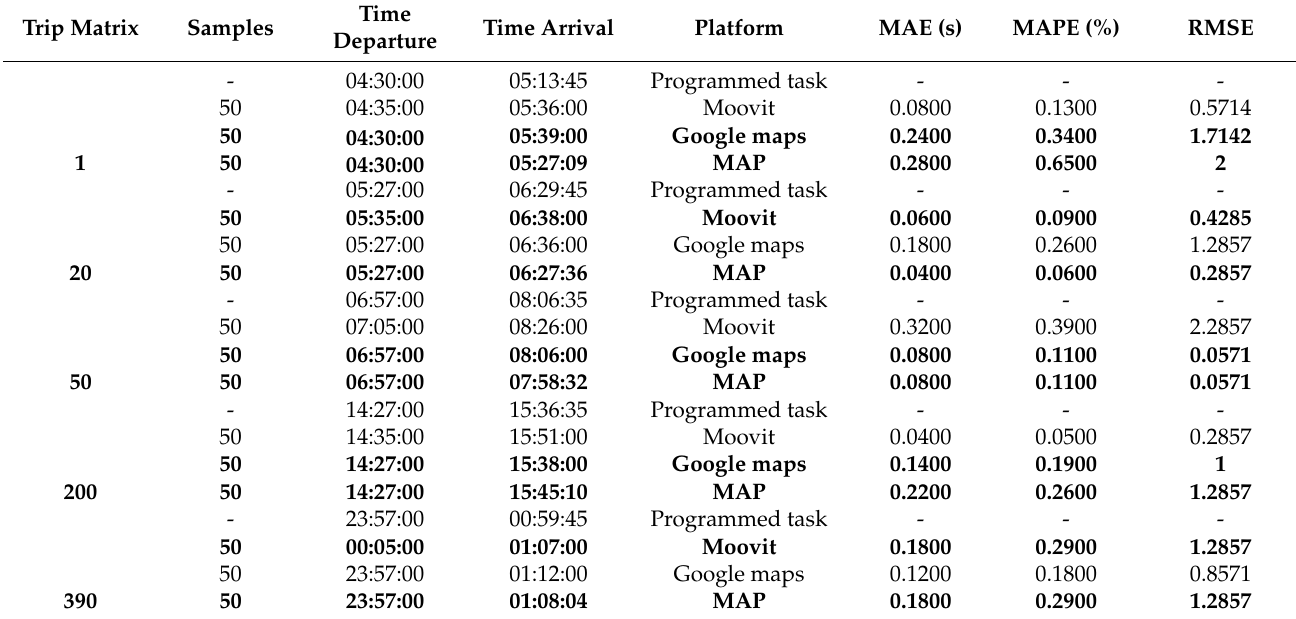
Table 5. Comparison of the prediction errors for MAP vs. Programed Task, Moovit vs. Programed Task, and Google vs. Programed